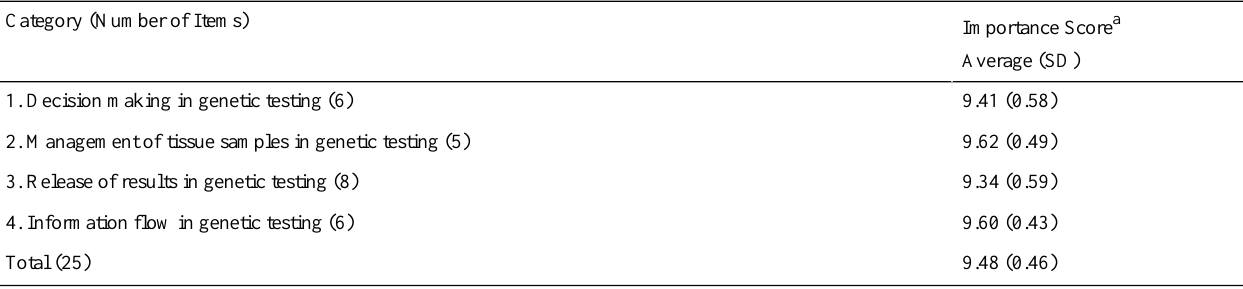
Table 2. The categorization of the draft ethical